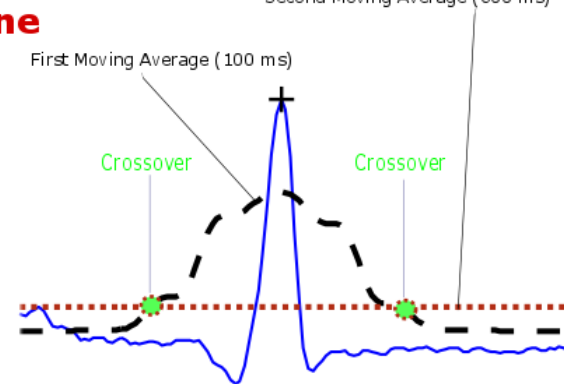
Figure 1. Demonstration of the use of Two Moving Averages in Economics and Digital Medicine. ( a ) Detection of the 11 September 2001 collapse in the NASDAQ composite index for the calendar year 2001 ( b ) Detection of QRS complex in the electrocardiogram signal.